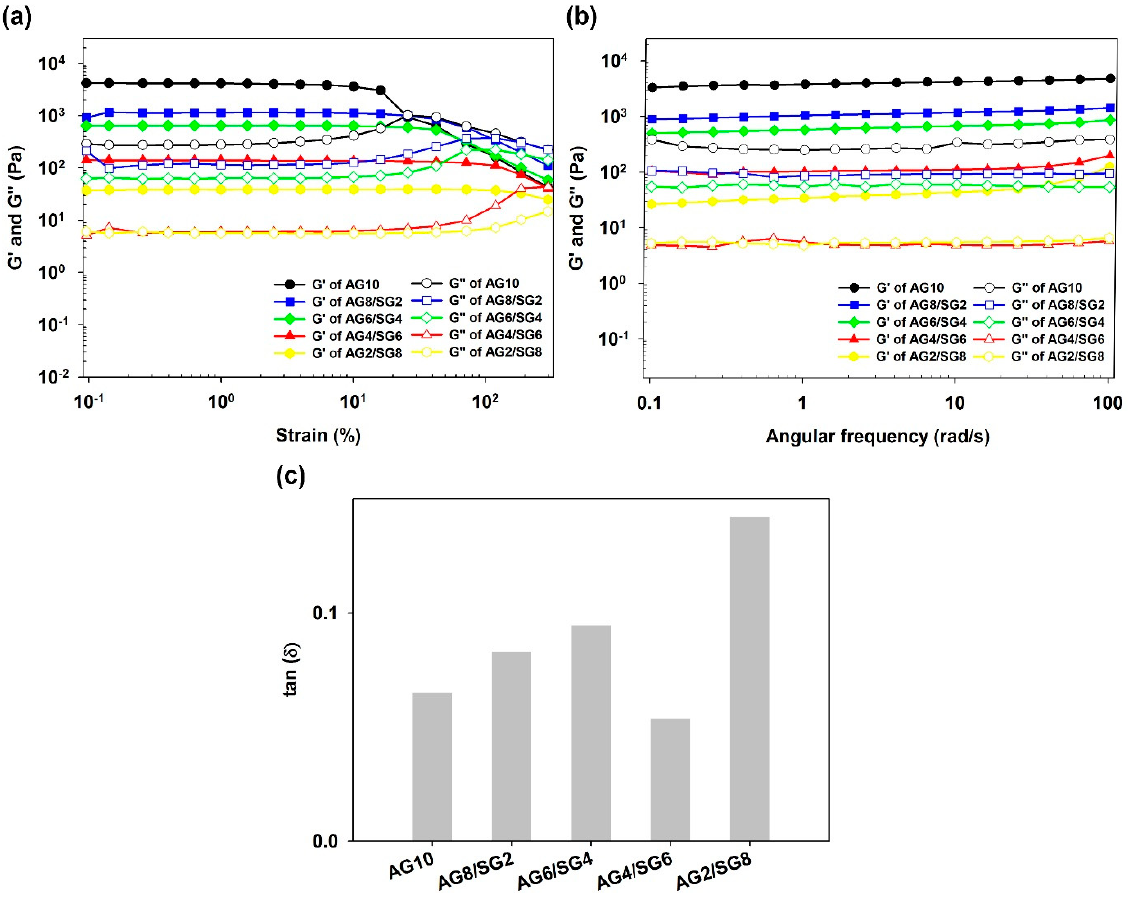
Figure 2. Storage modulus (G’) and loss modulus (G”) of ( a ) strain sweep for agarose and agarose/succinoglycan hydrogels at frequency of 1 Hz at 25 °C. ( b ) Angular frequency dependencies of G’ and G” for hydrogels with different agarose/su- ccinoglycan ratios. ( c ) The loss tangent (tan δ = G”/G’) of agarose/succinoglycan hydrogels when the angular frequency is 1 rad/s.